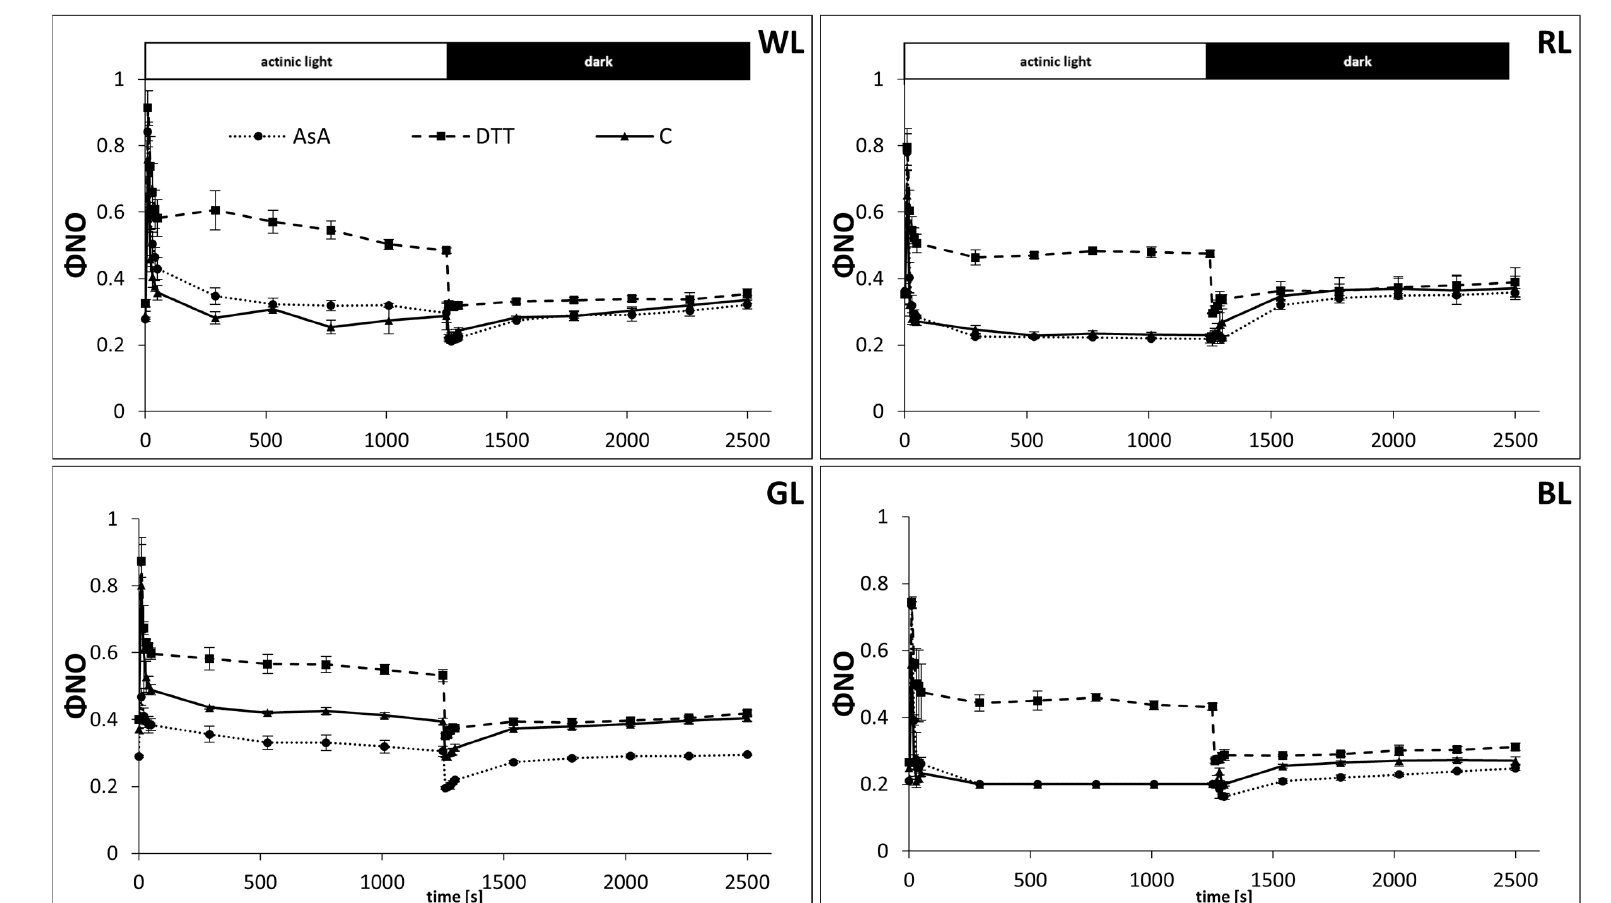
Figure 7. Measurement of the quantum yields of non-regulated energy dissipation in PSII, Φ NO, in leaves of tomato plants ( Solanum lycopersicum L. cv. Malinowy Ozarowski) grown under different light conditions (see Material and Methods for details). 10 mm diameter leaf discs were infiltrated with 10 mM ascorbic acid (AsA) or 5 mM dithiothreitol (DTT), or distilled water (C, control) for 30 min in the dark, followed by pre-illumination at 500 µ mol m − 2 s − 1 of RGB light for next 30 min. The dynamics of the Φ NO were determined in re-darkened leaf samples illuminated for 20 min at 185 µ mol m − 2 s − 1 of blue actinic light (AL = 450 nm) (induction), followed by 20 min of dark incubation (relaxation), and derived from the maximum fluorescence induced by saturation pulses (5000 µ mol m − 2 s − 1 , 0.8 s) at each of the measuring points [ Φ NO = 1/(NPQ + 1 + qL(Fm/Fo − 1))]. Each data point represents the average ± SD of six independent measurements ( n = 6).